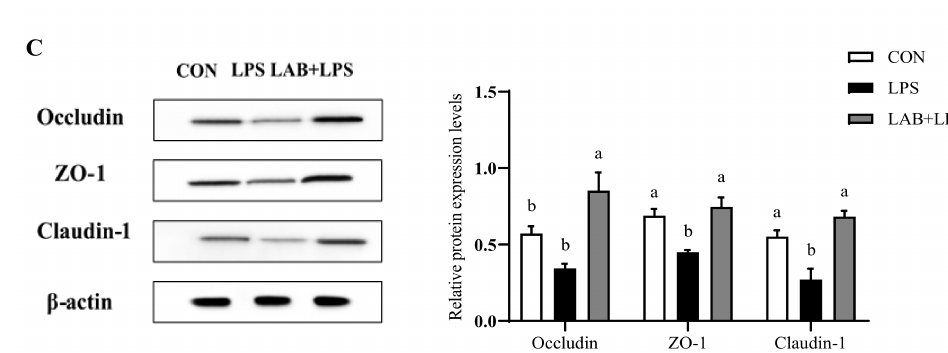
Figure 1. The effects of LAB supplementation on the serum diamine oxidase activity and intestinal tight junction protein expression in weaned piglets. ( A ) DAO activity in the serum. ( B ) The jejunal protein expression, based on Western blotting and statistical analysis, of occludin/ β -actin, ZO- 1/ β -actin, and claudin-1/ β -actin. ( C ) The ileal protein expression, based on Western blotting and statistical analysis, of occludin/ β -actin, ZO-1/ β -actin, and claudin-1/ β -actin. Data are presented as means ± SEMs ( n = 6). a,b Mean values within a row with different superscript letters indicate significant differences ( p < 0.05). CON—non-challenged piglets fed a basal diet; LPS—LPS-challenged